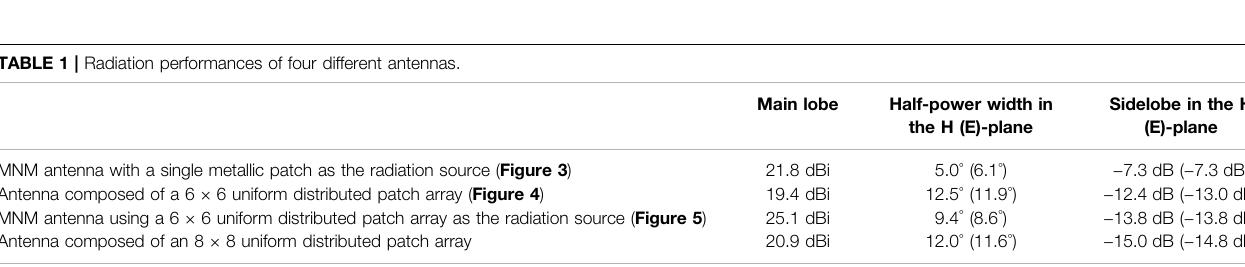
Main lobe Half-power width in Sidelobe in the H the H (E)-plane (E)-plane